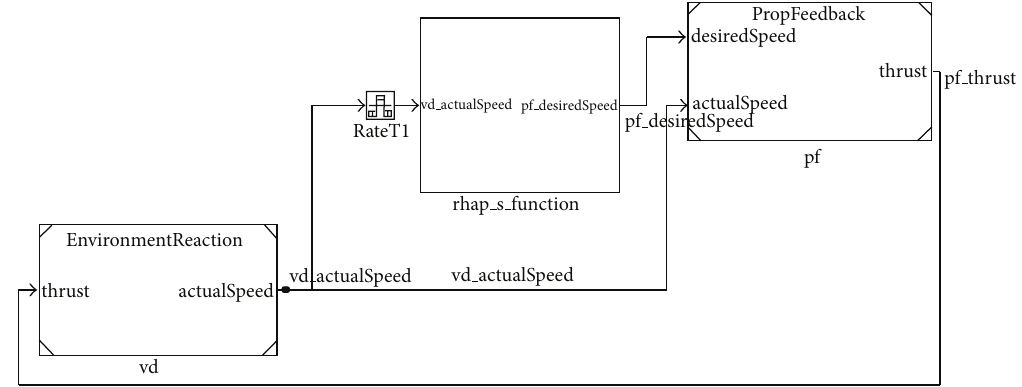
Figure 7: Generated Simulink model.